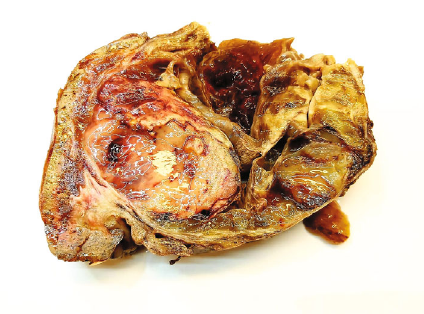
Figure 6: Surgical specimen — analysis con fi rmed the lobulated, multilocular, cystic-solid, and heterogeneous hepatic tumor, with a fi brous pseudocapsule, measuring 23 cm × 12 : 5 cm .